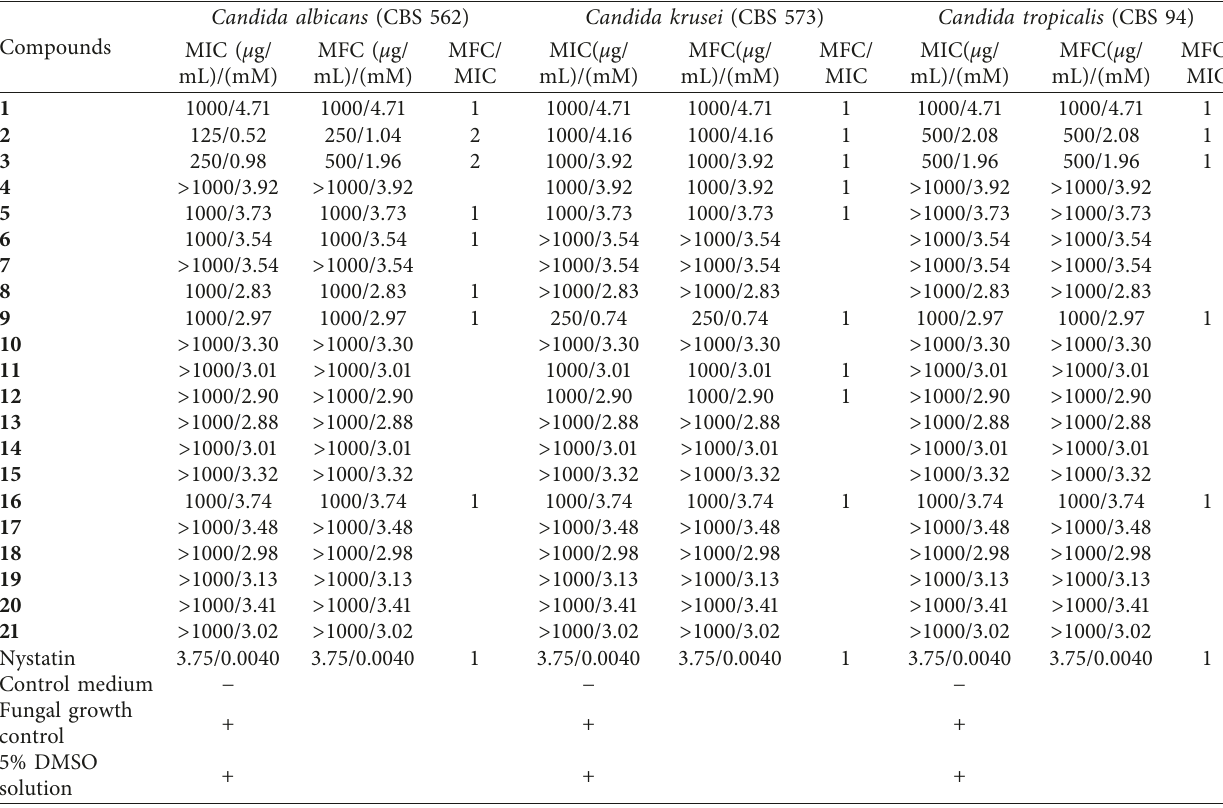
Table 1: Minimal inhibitory and fungicidal concentrations (MFC/MIC) of 3,5-dinitrobenzoic acid and its derivatives expressed in µ g/mL and